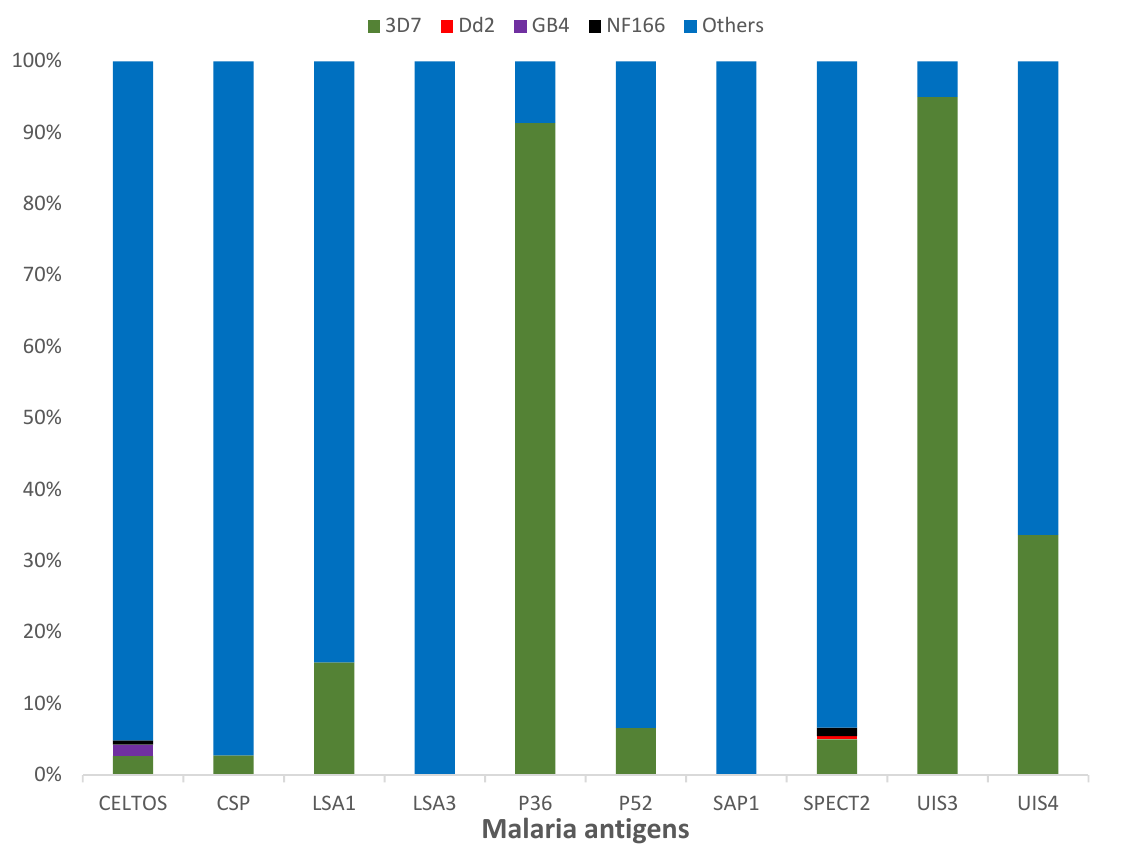
Figure 2. Frequencies of ten liver-stage malaria vaccine candidates. Antigens’ names are listed on the x axis, while frequencies are on the y axis. The frequencies are stacked to 100%, and each color represents a variant or a group of variants. The laboratory strain 3D7 is represented in green.